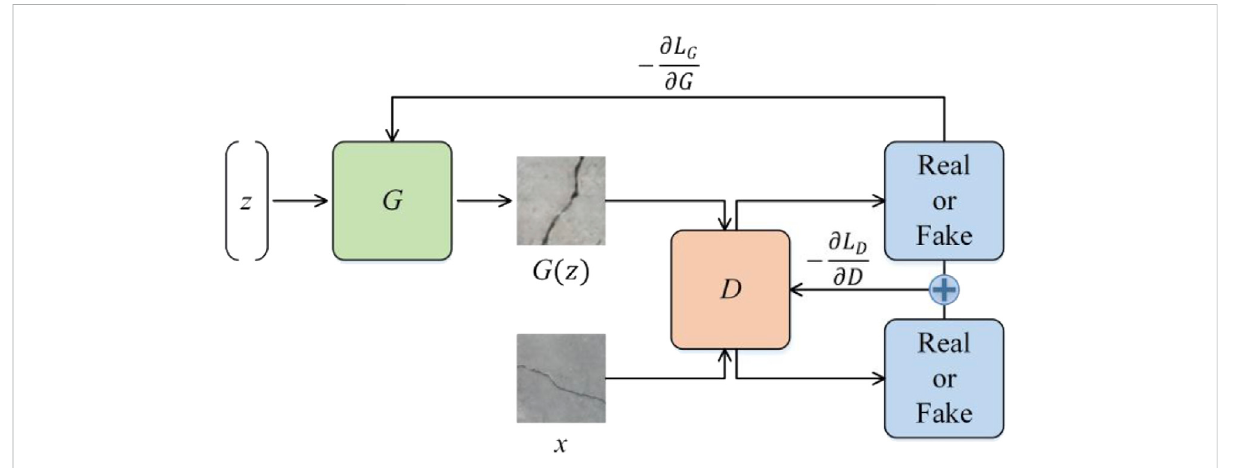
FIGURE 14 Training process of DCGAN for crack images (Huang et al.,